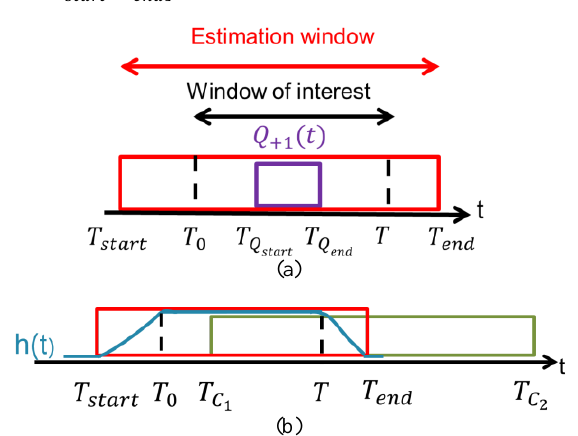
Figure 8 Illustrations of a) the estimation window and the window of interest b) temporal support of the output signal by the convolution with the distribution 𝑄 +1 (𝑡) , between 𝑇 𝐶1 and 𝑇 𝐶2 . The tapering window h(t) is in